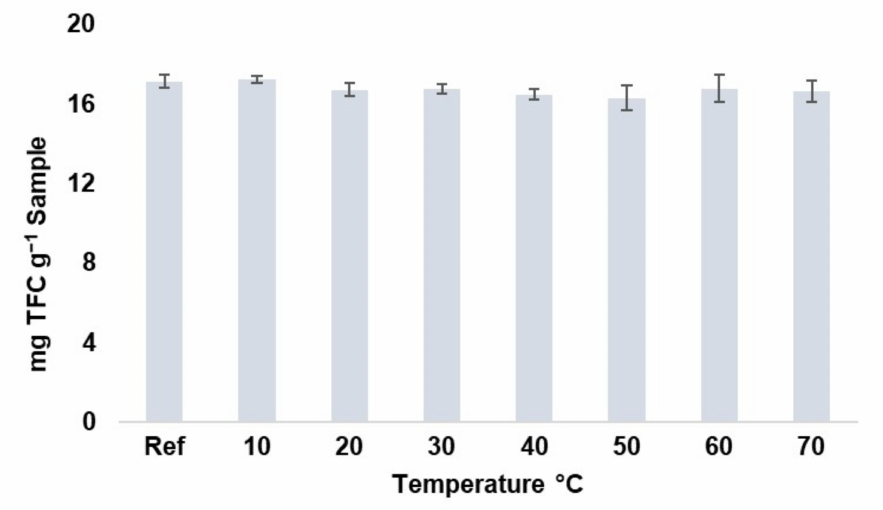
Figure 1. Total flavonoids content (TFC) stability at different temperatures (10–70 ◦ C) ( n =